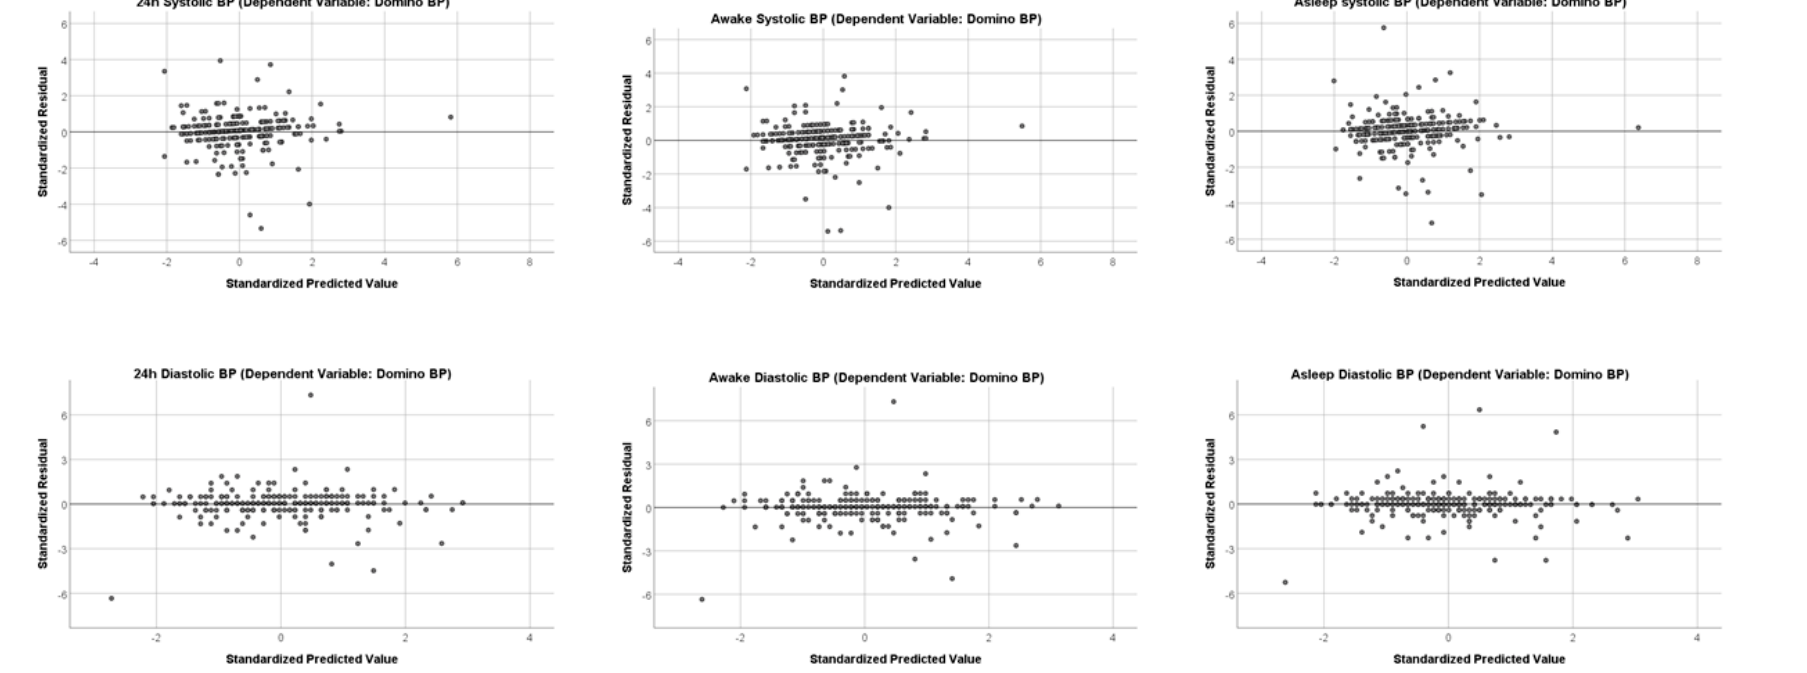
Figure 4. Residual Plots. Independent Variable is SchillerBP for all Residual Plot.